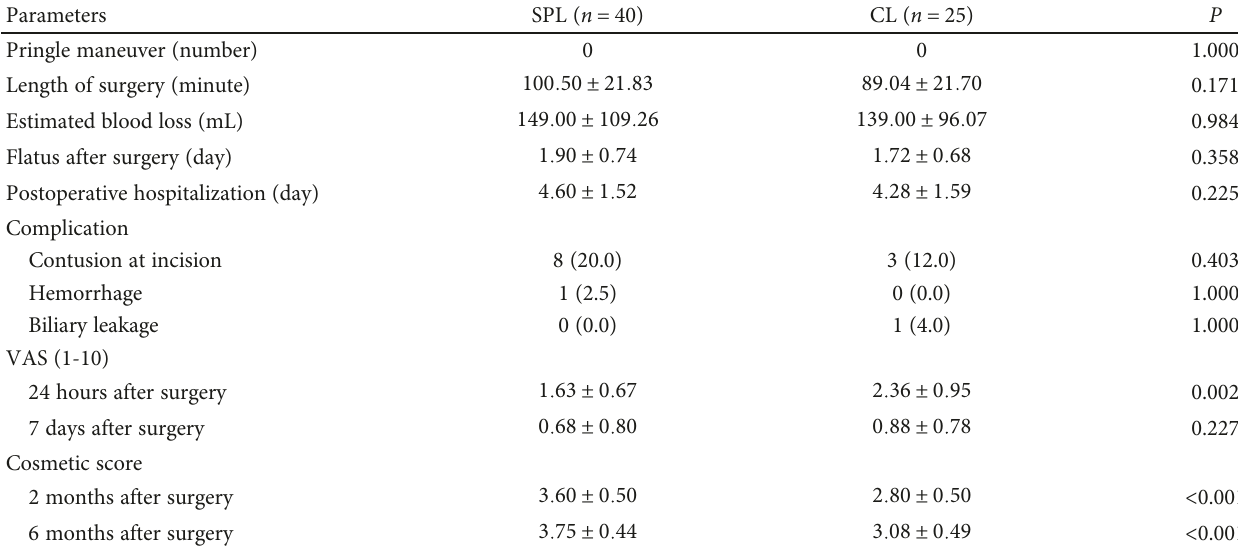
Table 2: Patient ’ s operative details and outcomes.